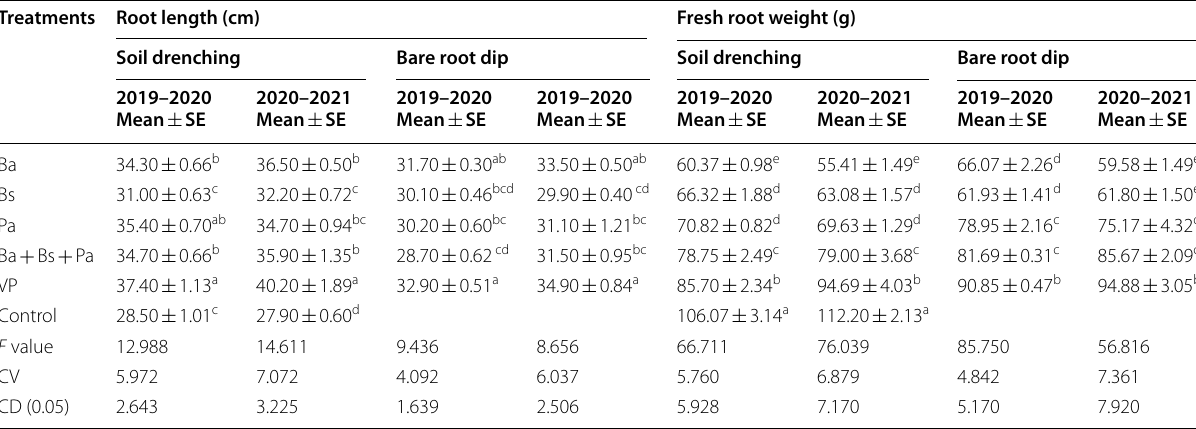
Data shown correspond to the mean of four replicates SE. Means with the same alphabet letters on each columns are not significantly ( P < 0.05 ) different ± CD critical difference, CV coefficient of variation, SE standard error. Treatment details: Ba Bacillus amyloliquefaciens DSBA 11, Bs Bacillus subtilis DTBS 5, Pa Pantoea agglomerans ; Ba Bs Pa (Consortium), VP Velum Prime ® (500 g a.i./ha) as positive control + + Table 7 Effect of PGPR isolates applied as soil drenching and bare root dipping prior transplanting on nematode multiplication in tomato plants infested by M. incognita under protected cultivation Treatments No. of